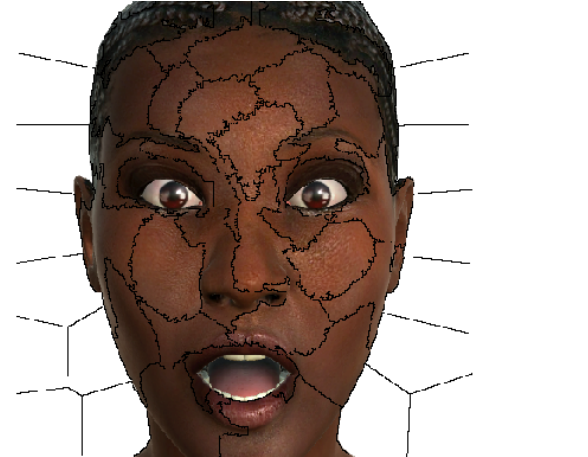
Figure 3. A facial expression image of the UIBVFED dataset showing the areas divided by super-pixels (nº super-pixels =